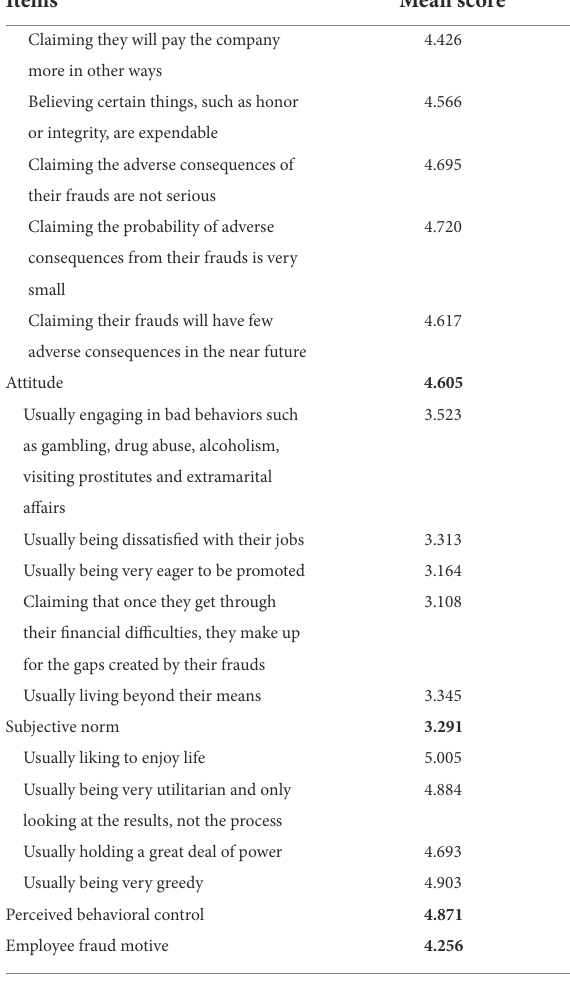
TABLE 11 Internal structure of employee fraud